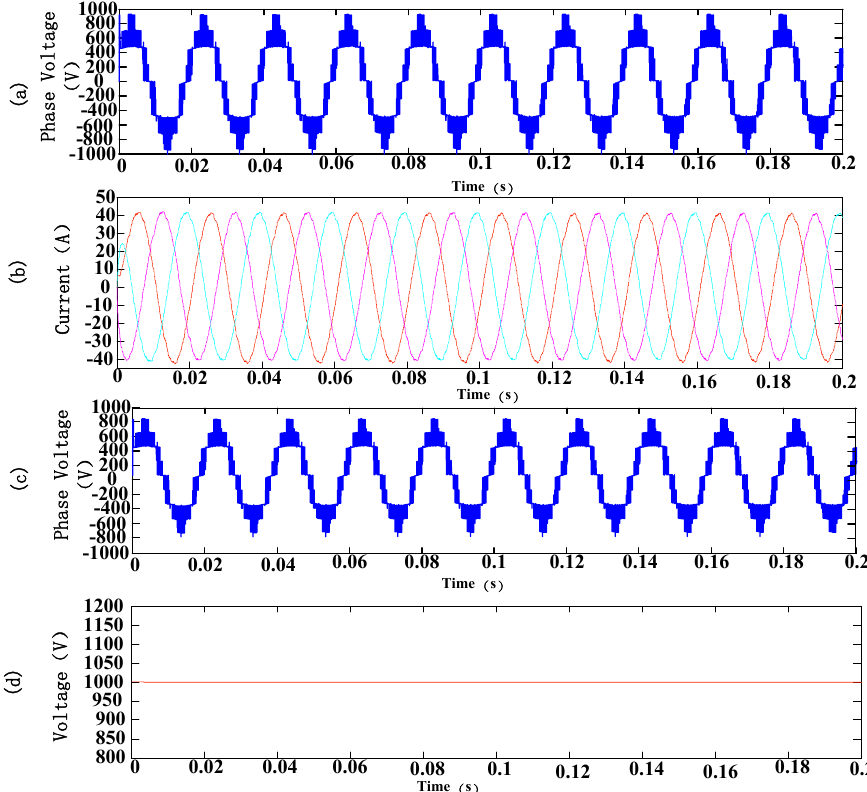
Figure 10. Simulation results of the hybrid nine-arm high-voltage inverter under normal condition. ( a ) Upper line voltage ( u a 1 − u b 1 ); ( b ) Upper output current i a 1 , i b 1 , i c 1 ; ( c ) Lower line voltage ( u a 2 − u b 2 ) ; and ( d ) DC side voltage U dc .